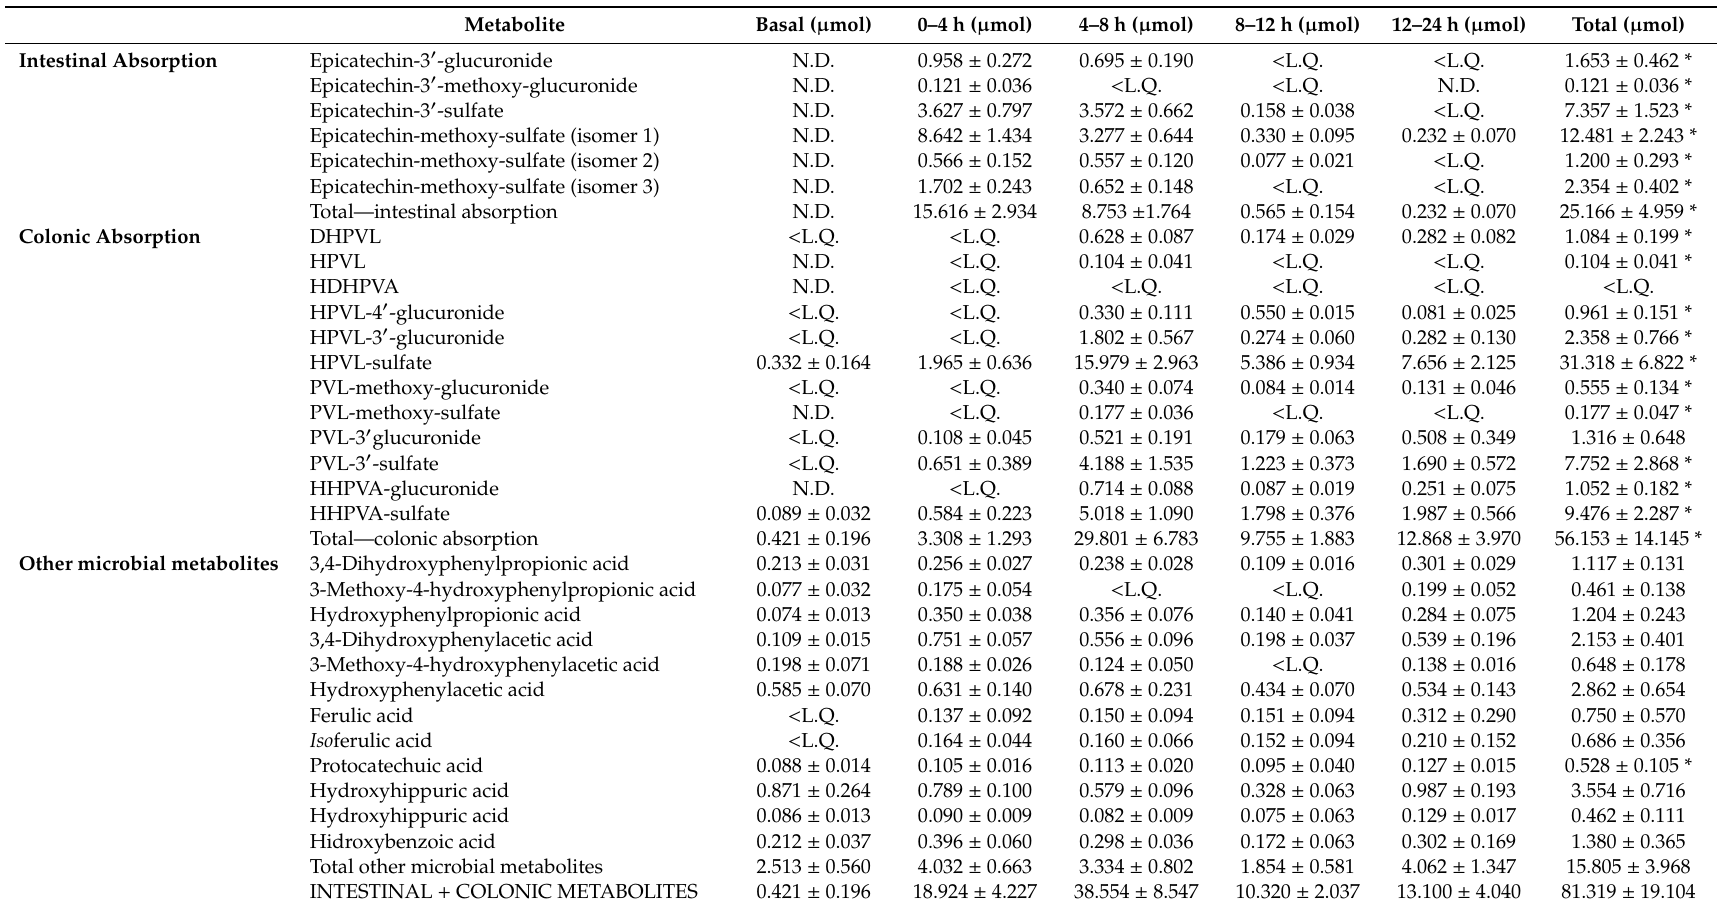
Table 5. Metabolites excreted in urine (from 0 to 24 h) by healthy volunteers after consumption of the flavanol-rich soluble cocoa product (CC-PP) containing 68.25 mg of